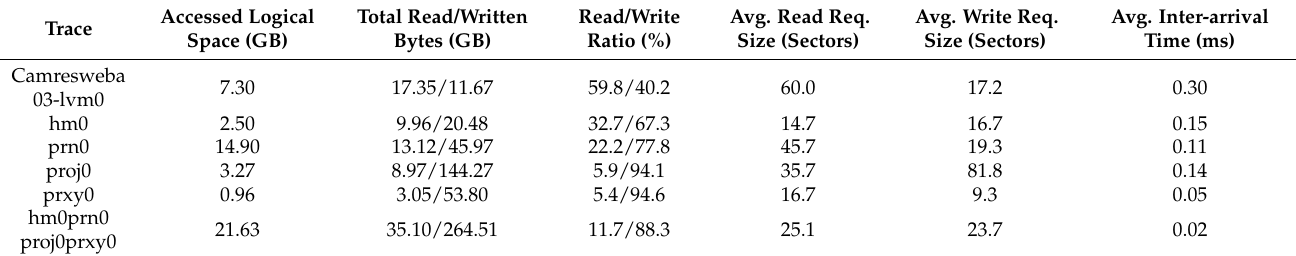
Table 1. MSRC trace